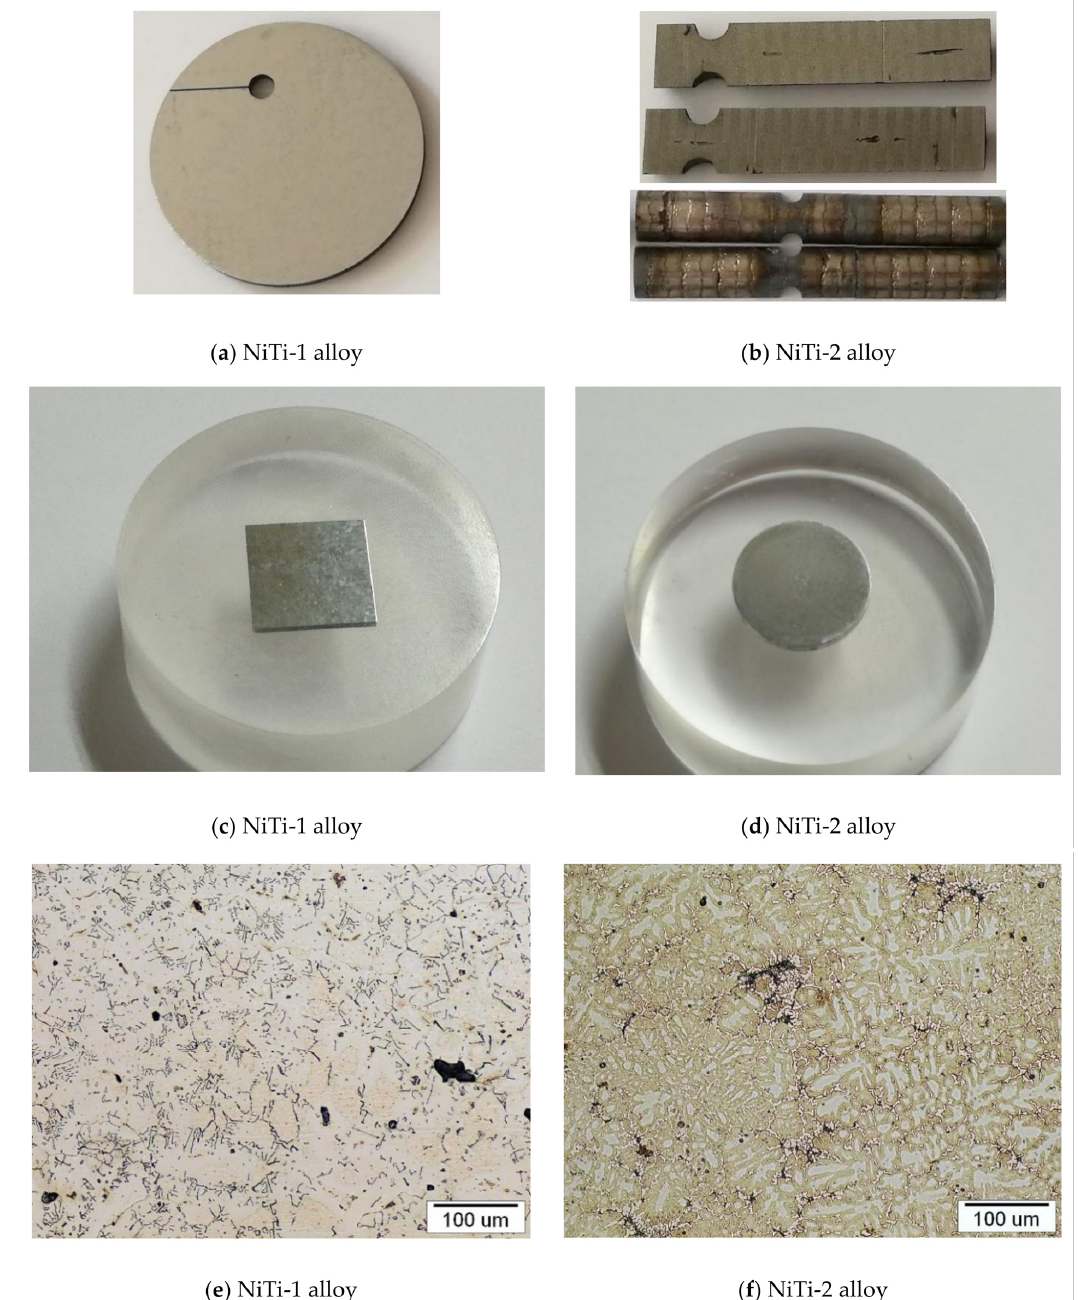
Figure 2. NiTi-1 and NiTi-2 samples: ( a – d ) macro-view, ( e , f ) optical